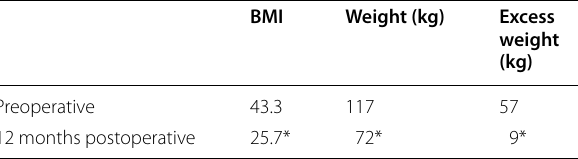
Table 1 Comparison of preoperative weight, BMI and excess weight and 12 months postoperative in all patients